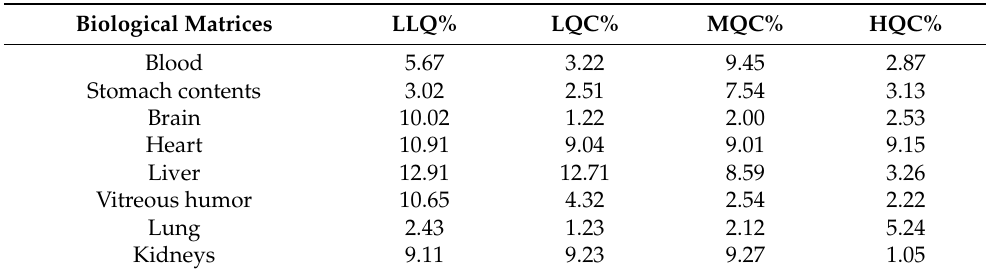
Table 11. Lower limit of quantification (LLQ), low-quality control (LQC), medium-quality control, (MQC), and high-quality control (HQC) calculated in each matrix, in triplicate, intracutaneous and intercurrent to carbofuran.